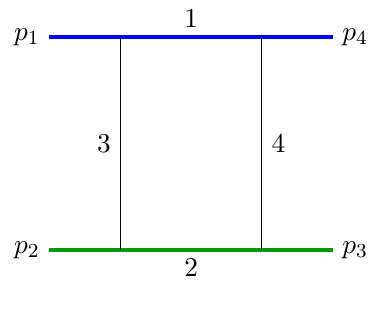
Figure 2. The box